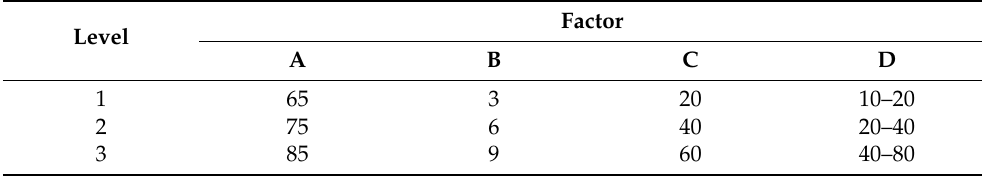
Table 1. Orthogonal design of the similar material.